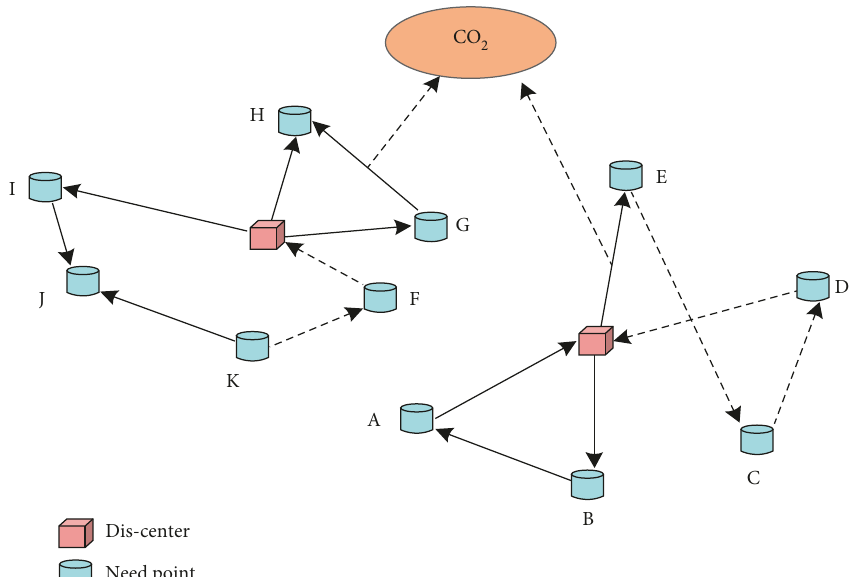
Figure 2: Urban distribution optimization network considering carbon penalty